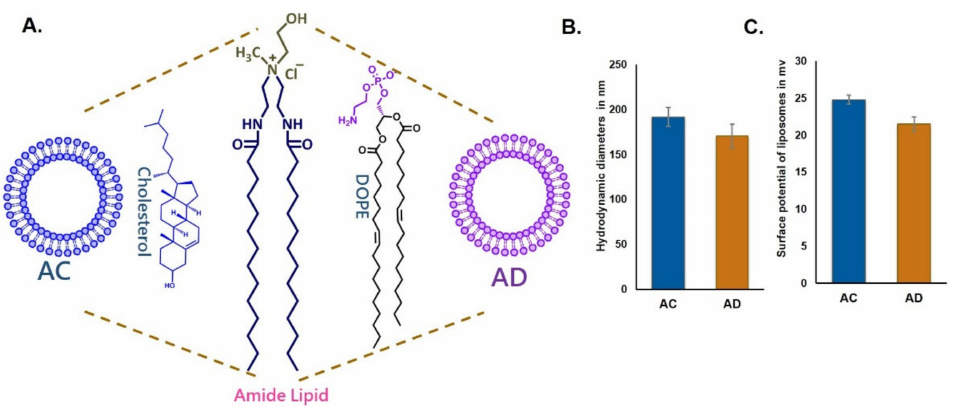
Figure 1. Schematic representation of lipid structures and liposomes of AC and AD ( A ). Particle sizes of liposomes AC and AD ( B ). Zeta potentials of liposomes AC and AD ( C ). Further transfections were carried out using AC and AD liposomes to pretreat en- dothelial cells with the caveolae blockers, nystatin and filipin III, at varying